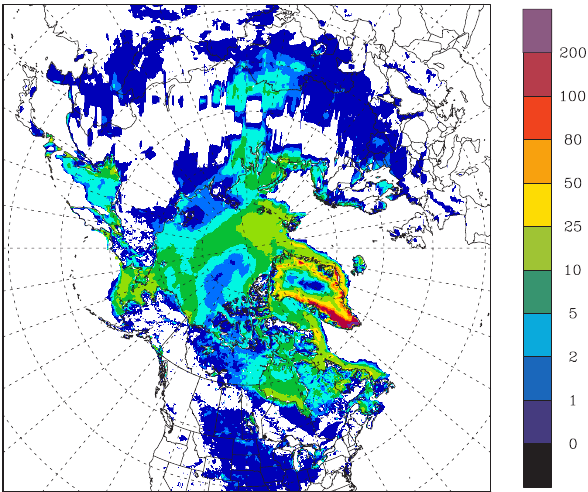
Fig. 12. Winter season blowing snow sublimation from empirical formula over DJF 2006/2007. Units in mm